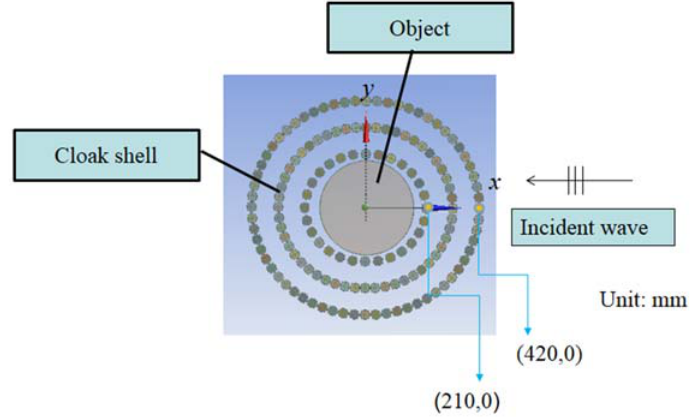
Figure 10. Geometry setup used in numerical analysis: plane waves from the right side of the cloak shell are guided along a pre ‐ determined path around the cloak shell away from the cylinder object (radius = 185 mm, height = 30 mm) inside the shell.